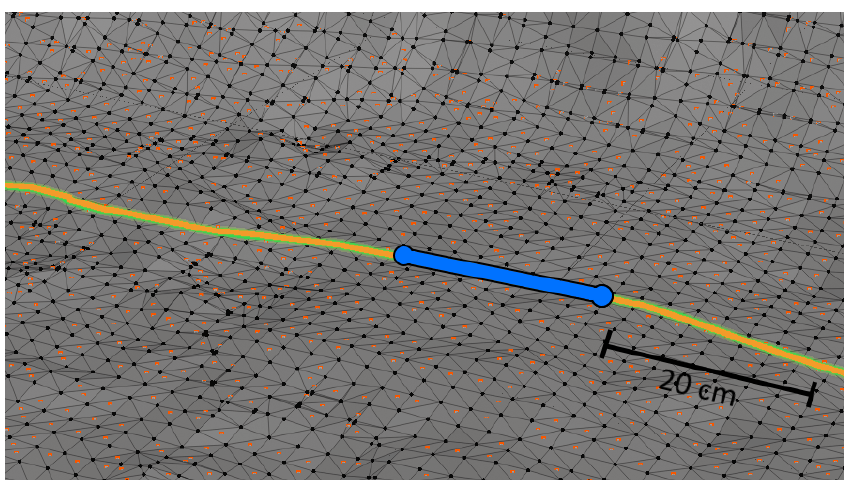
Figure 9. Fragment of a triangular mesh. The figure shows: vertices of the triangle mesh (black dots), scan points captured in 0.1 s during localization (orange dots), robot localization (yellow curve), reference path (green curve), localization of the robot when the LiDAR was capturing measurement points (blue line).